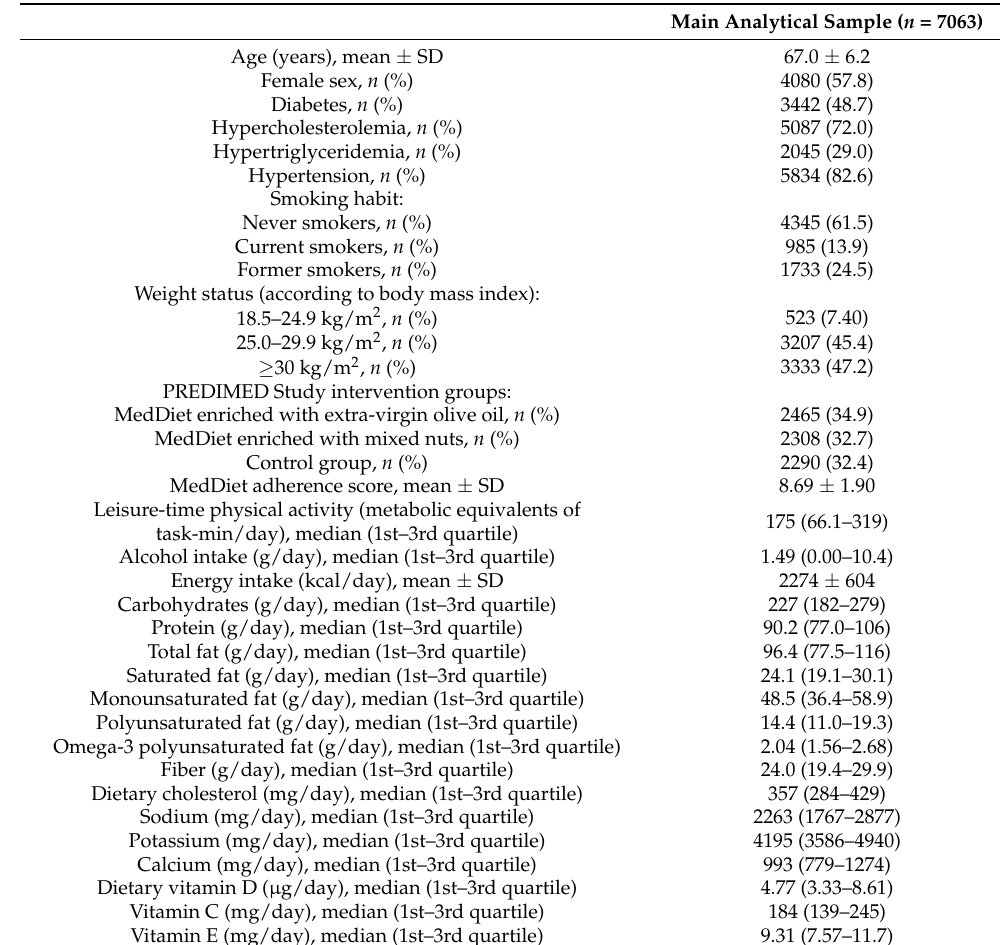
Table 1. Study population 1